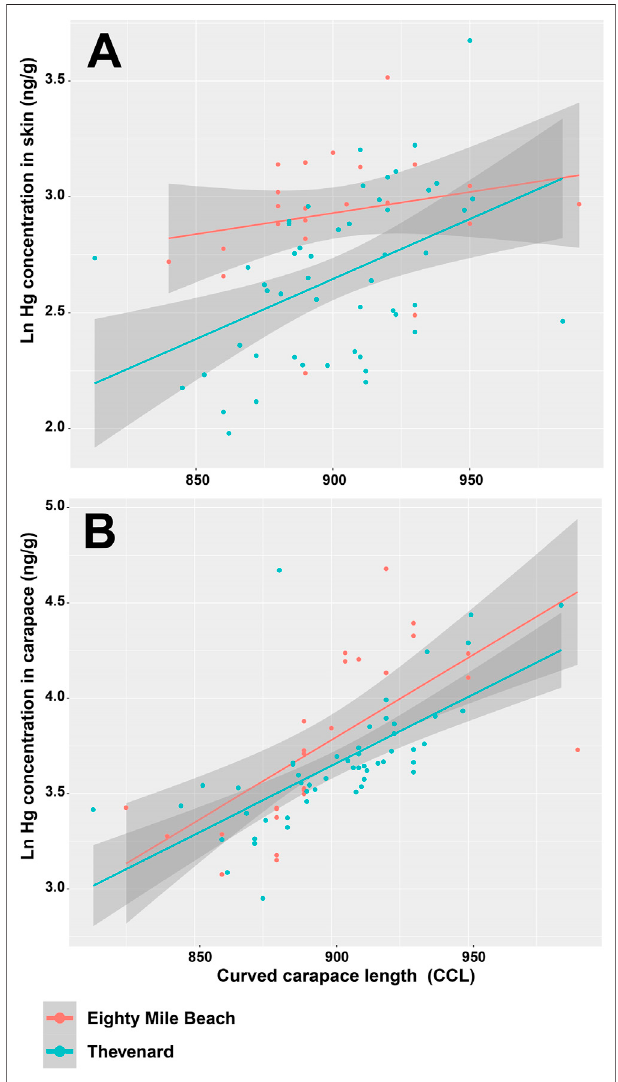
FIGURE 4 | Scatter plots and linear regression lines of fl atback CCL versus Hg concentrations in (A) skin and (B) carapace of turtles from Eighty Mile Beach (pink) and Thevenard Island